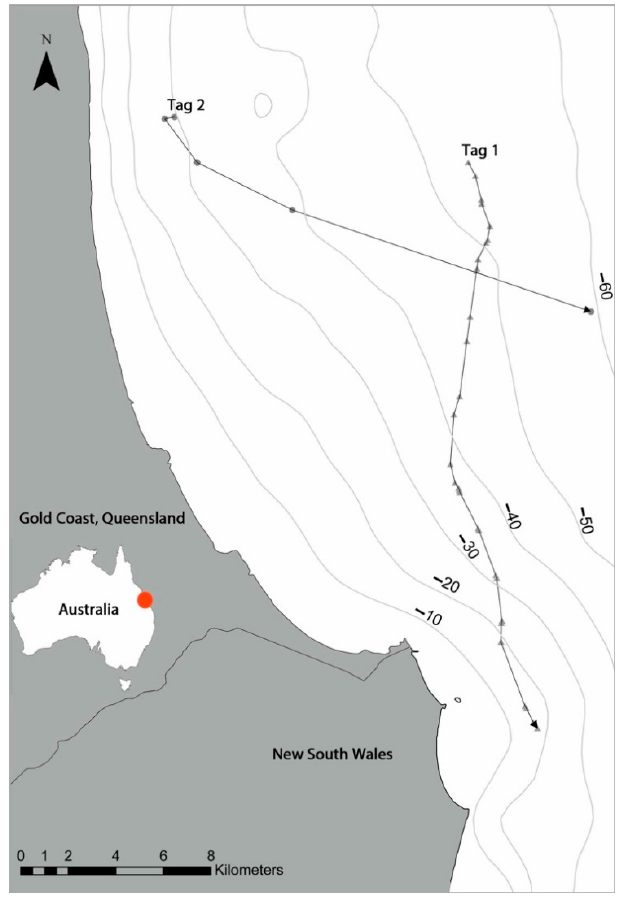
Figure 1. Map of study area and two tracks with arrows indicating direction of movement. The received locations from the GPS/GSM tag are shown by triangles (Tag 1) and dots (Tag 2). Bathymetry contour lines in 10 m depth intervals.